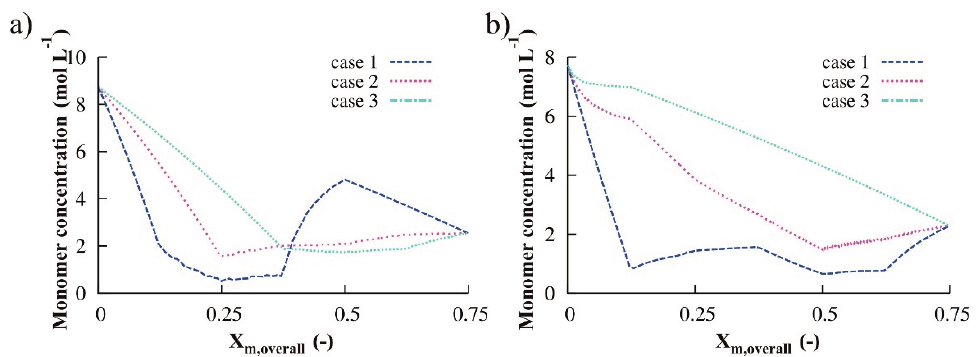
Figure 4. Monomer concentration as a function of overall conversion for the three cases in ( a ) the multi-objective optimization (MOO) of ARGET ATRP of BMA using a fed-batch monomer program (Figure 3) and ( b ) MOO of NMP of styrene using a fed-batch monomer program (Figure